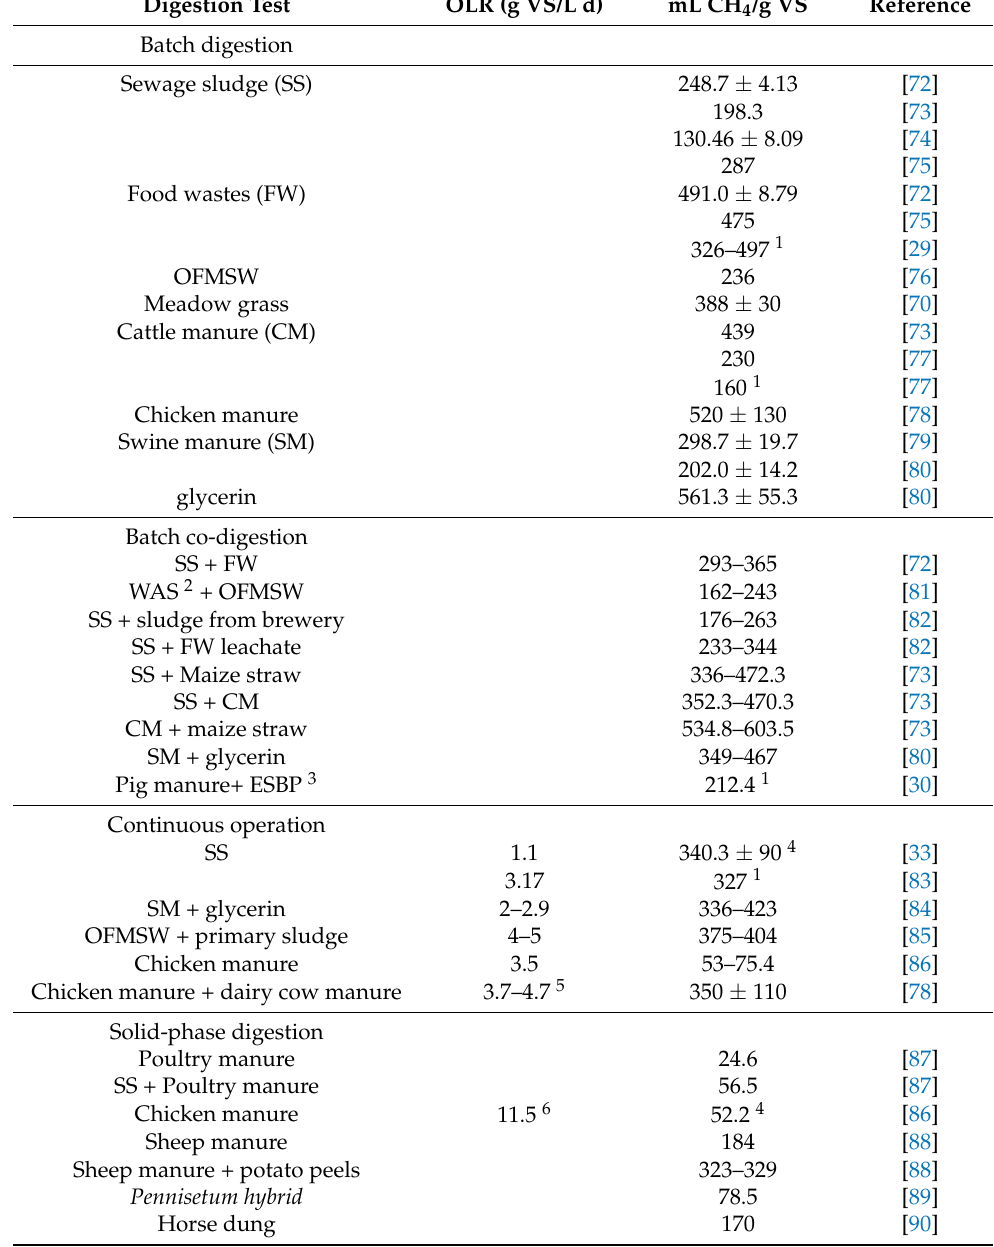
Table 2. Methane yields reported in the literature under different conditions: Batch digestion, co-digestion, and continuous digestion